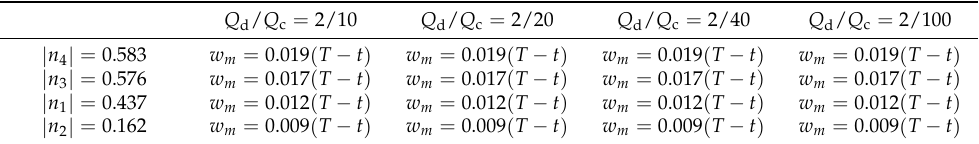
Table 3. The fitting model of w m with different | n | and Q d / Q c in the pinch-off stage.